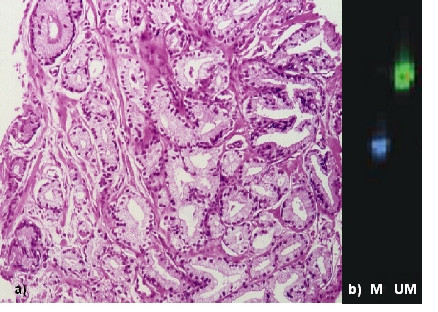
a) Prostate biopsy showing well differentiated adenocarcinoma of the prostate prior to neoadjuvant antiandrogen therapy (H&E staining). b) GSTP1 promoter methylation analysis of the tumor displaying both methylated (M, 92-base pairs (bp) product, blue fluorescence; tumor DNA) and unmethylated (UN, 99-bp product, green fluorescence) GSTP1 promoter sequences.